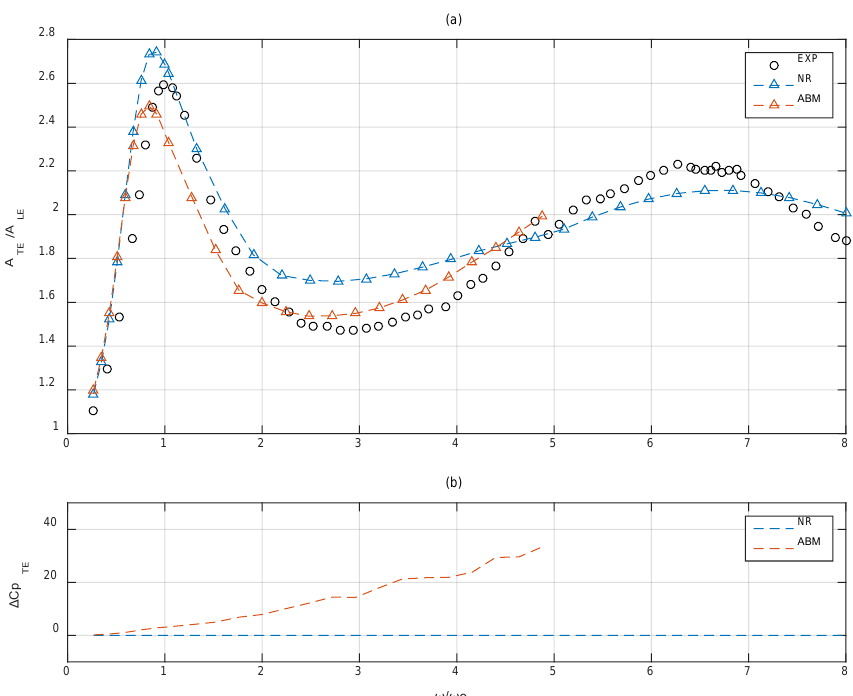
Figure 11. Comparison with experimental data (denoted by circles) from [34] for the case of a flexible flat plate with D = 0.018 Nm, h o = 0.004 m and Re = 6000: ( a ) TE / LE amplitude response ratio and ( b ) maximum pressure difference recorded at the TE during simulations.